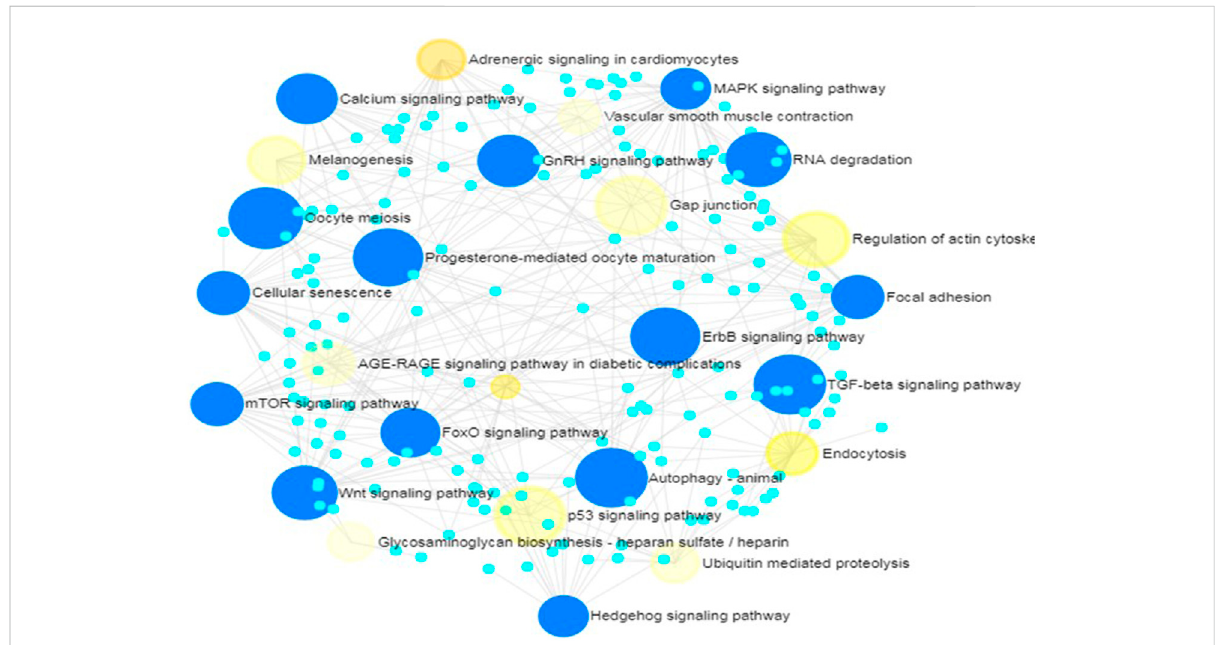
FIGURE 6 NetworkofenrichedKEGGpathwaysfortargetgenesofnon-additivelyexpressedmiRNAs.SmallcyancirclesrepresenttargetgenesofmiRNAs withnon-additiveexpression;YellowcirclesrepresentKEGGpathwaysenrichedbythetargetgeneswith p -values < 0.05;Largebluecirclesrepresent KEGG pathways enriched by the target genes with corrected p -values <